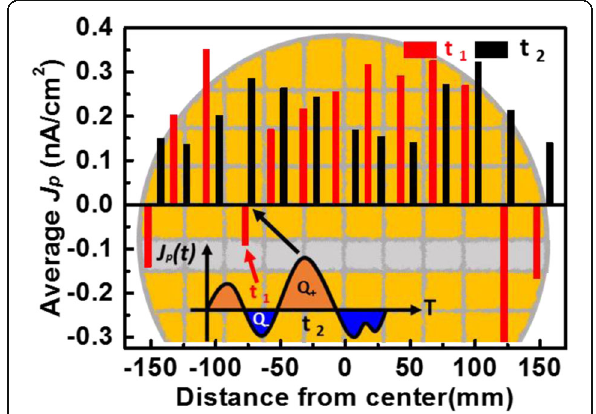
Fig. 1 Distribution of plasma-induced charging rate in the center line of the wafer during etching process at different times. The plasma charging polarity on a particular location may change over time